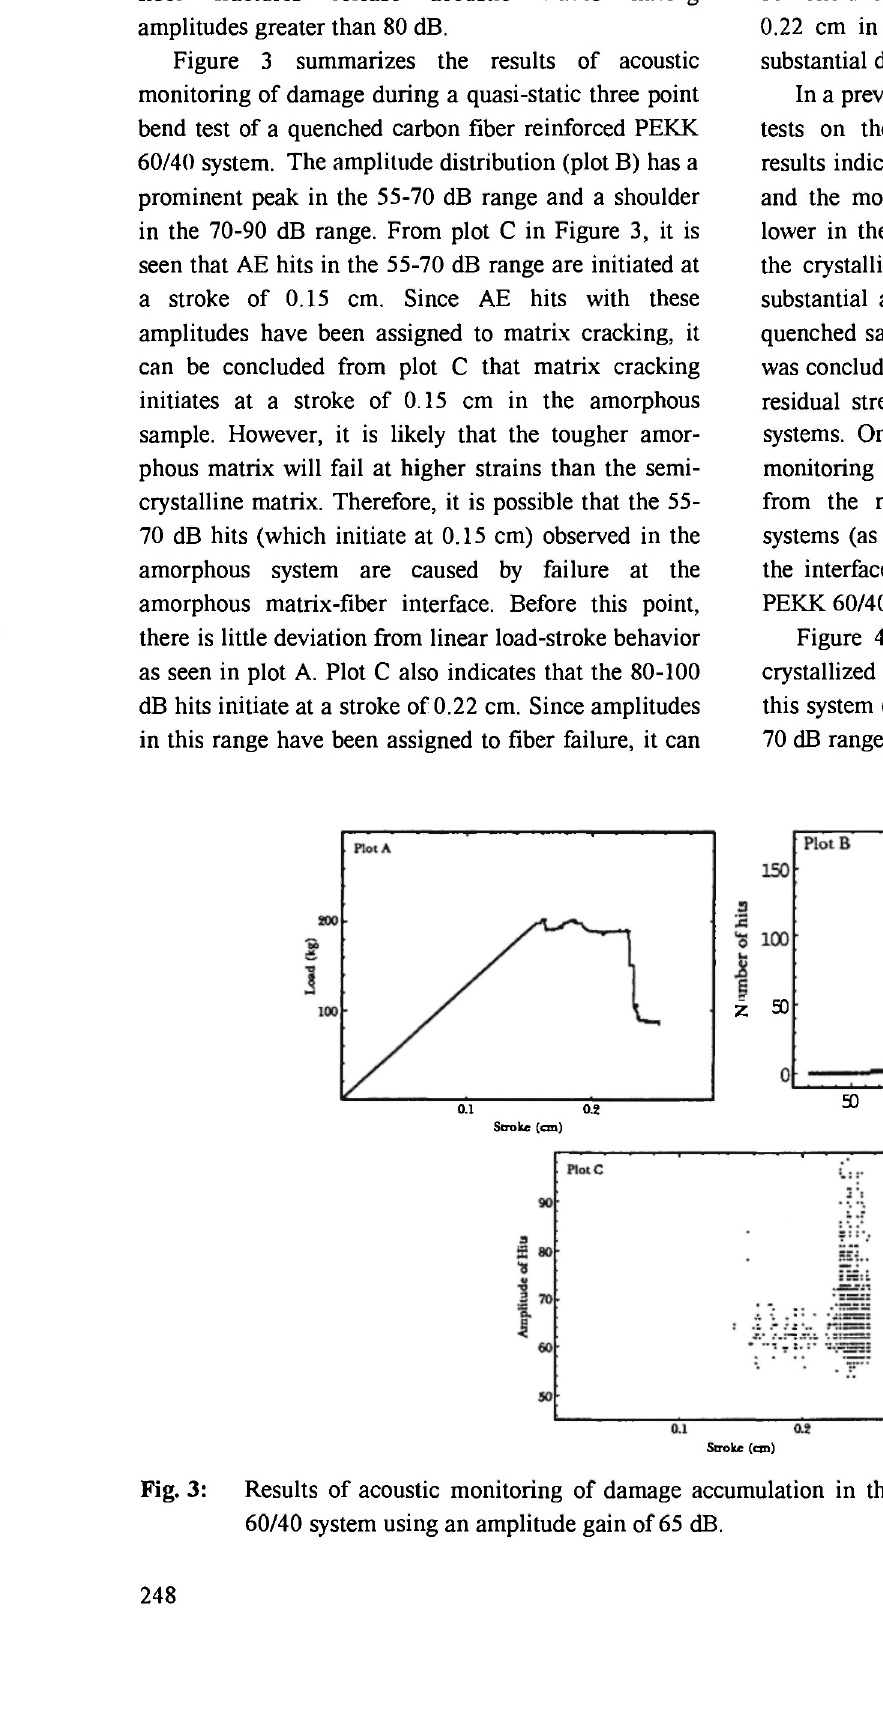
Fig. 3: Results of acoustic monitoring of damage accumulation in the quenched carbon fiber reinforced PEKK 60/40 system using an amplitude gain of 65